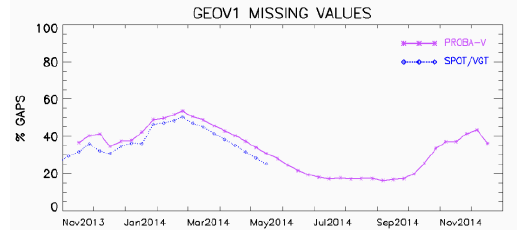
Figure 1: Temporal variations of missing values for SPOT/VGT (blue dashed line) and PROBA-V (purple solid line) GEOV1 products during the November2013-December2014 period.